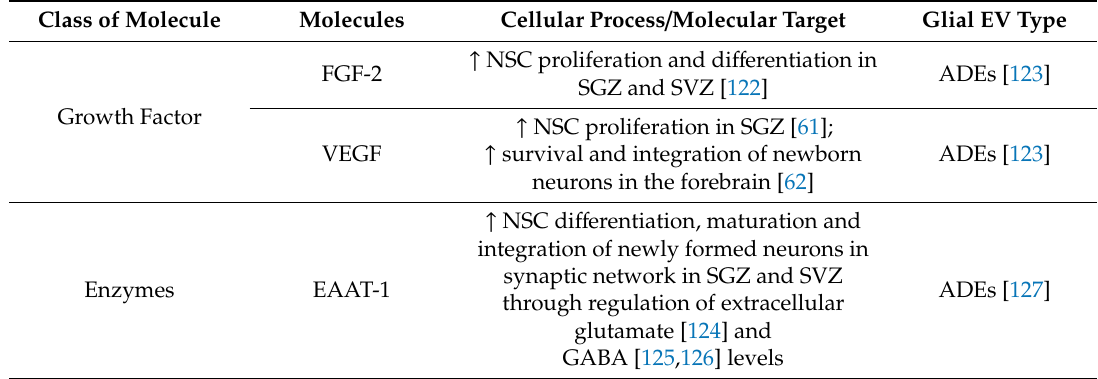
Table 2. List of di ff erent classes of pro- or anti-neurogenic molecules found in astrocyte-derived (ADEs) and / or microglia-derived (MDEs) extracellular